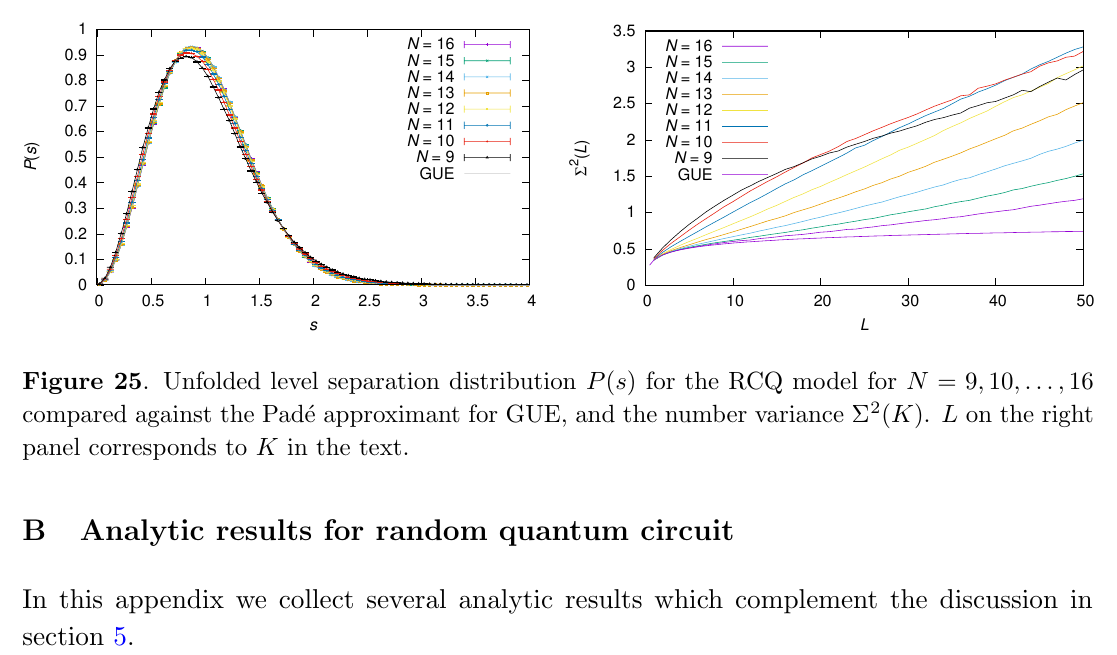
Table 1 . The value of smallest t min , de(cid:12)ned as the value of t when j Y ( (cid:11); (cid:12) = 0 ; t ) j 2 = j Y ( (cid:11); (cid:12) = 0 ; t = 0) j 2 has a single minimum as a function of t for the smallest (cid:11) . The value of such (cid:11) is also given. The number of samples is 240000 (cid:2) 2 (14 (cid:0) N ) = 2 for N = 10 ; 12 ; 14, 600000 (cid:2) 2 (18 (cid:0) N ) = 2 for N = 16 ; 18, 120000 (cid:2) 2 (22 (cid:0) N ) = 2 for N = 20 ; 22, 48000 for N = 24, 10000 for N = 26, 3000 for N = 28, 1000 for N = 30, 1500 for N = 32 and 110 for N = 34.